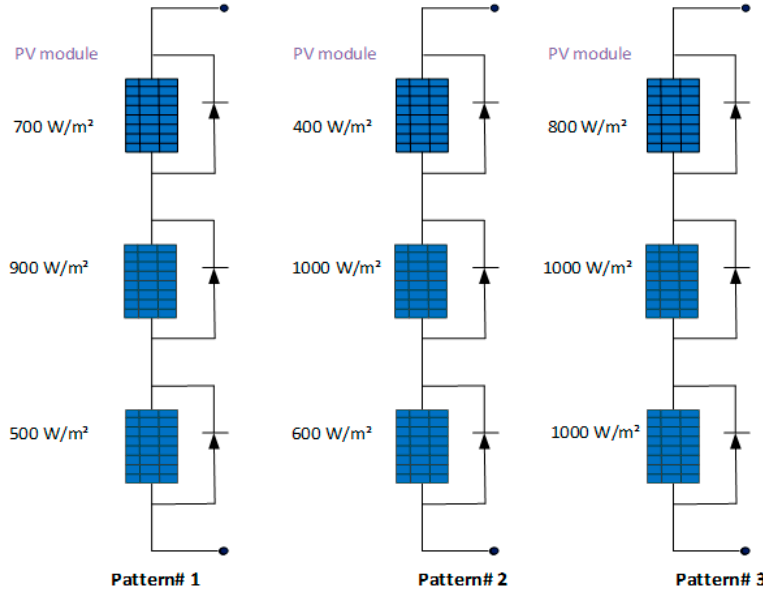
Figure 1. Photovoltaic systems (PVS) under different partial shading conditions.